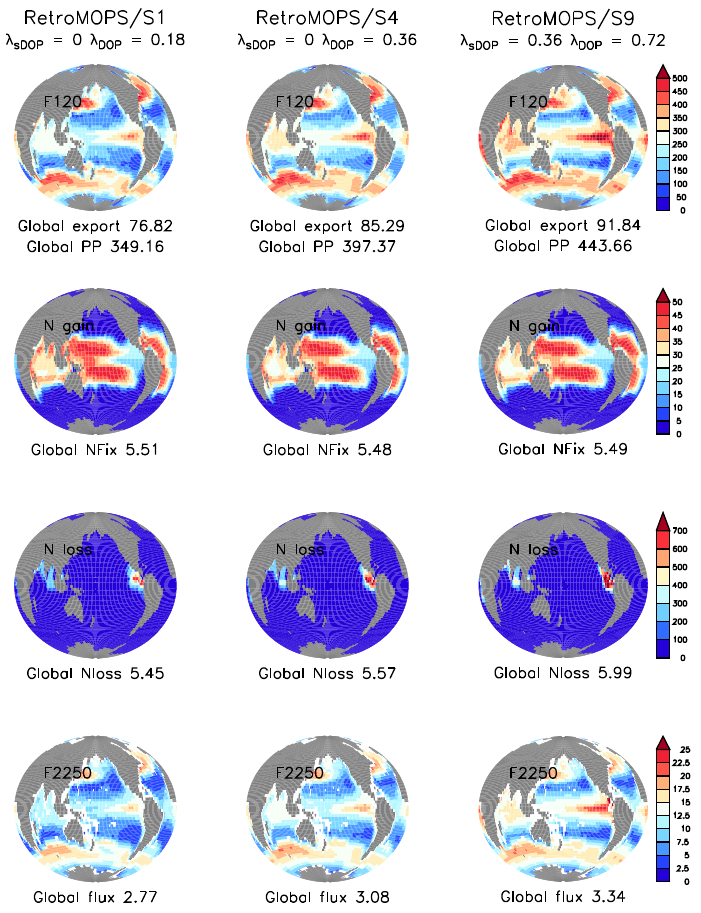
Figure 4. As in Fig. 2, but for three sensitivity experiments with model